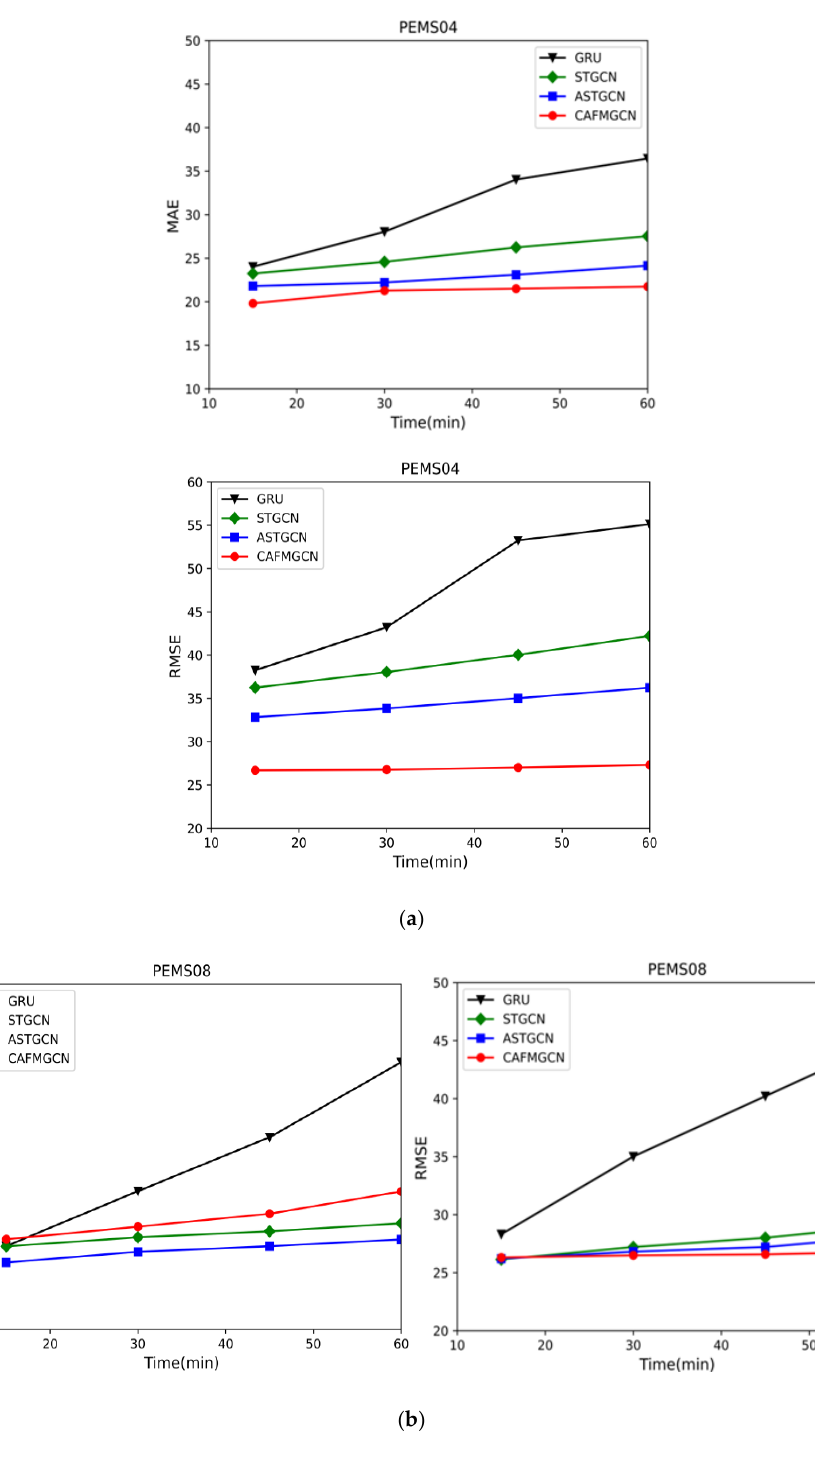
Figure 10. Comparison of prediction performance under different periods. ( a ) PeMSD4. ( b ) PeMSD8.